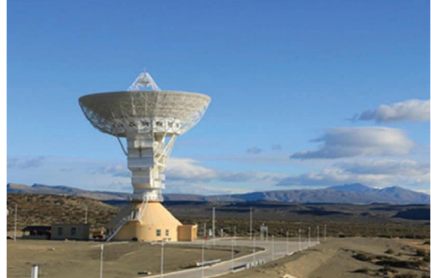
Figure 4: Argentina deep space station. (https://cn.chinadaily.com. cn/a/202007/24/WS5f1a2d7fa310a859d09d9ca5.html).